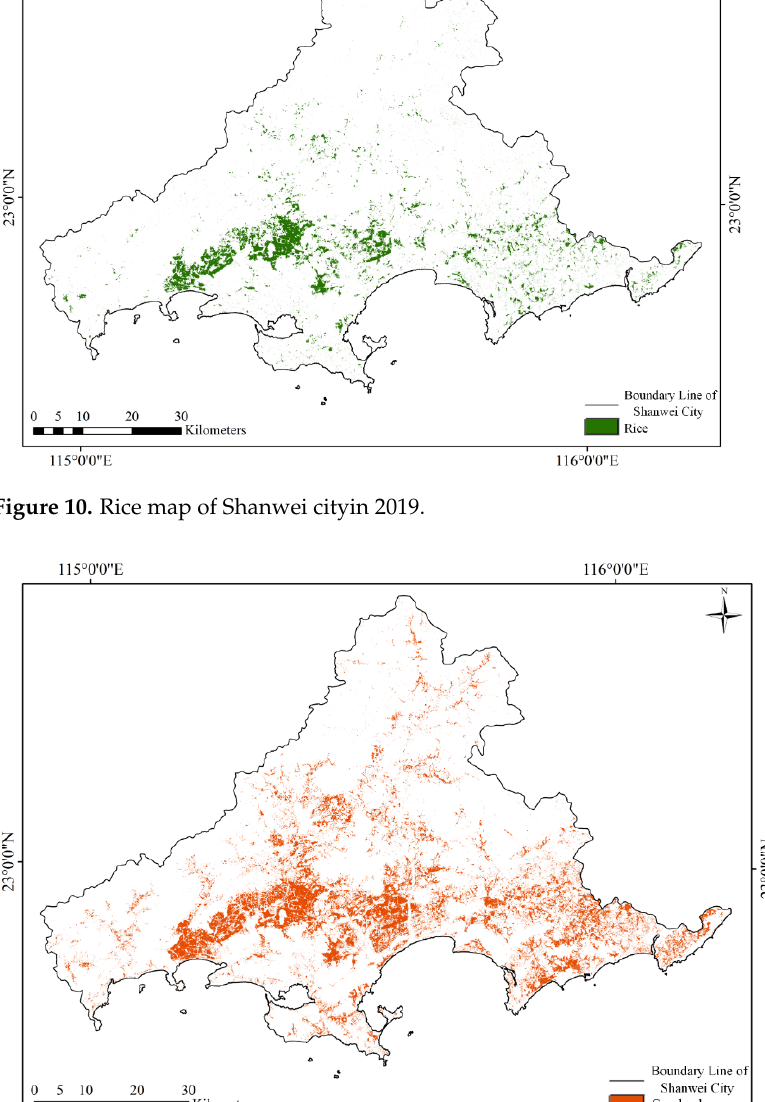
Figure 11. Cropland map of Shanwei city based on WorldCover.